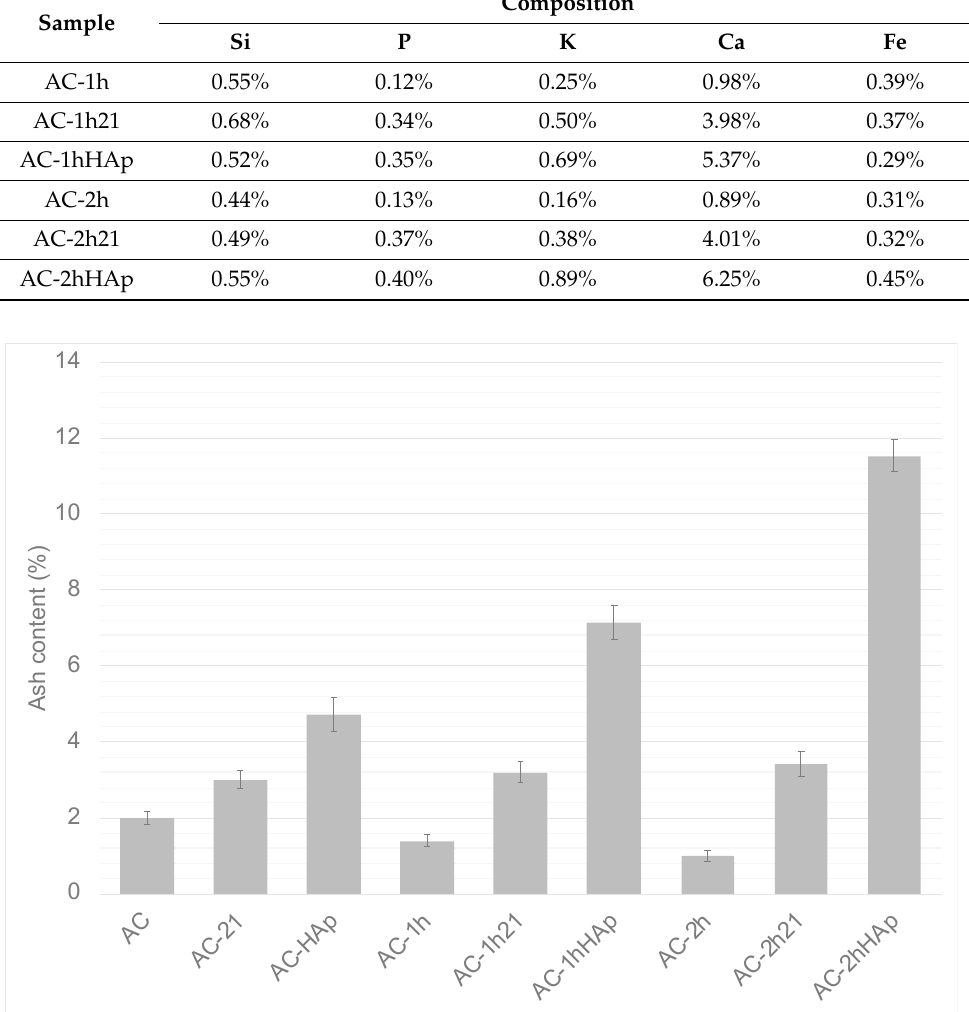
Figure 1. Ash content in percent of the different carbons tested (AC: activated carbon; 21: 21 days incubated; Xh: oxidized time; HAp: incubated for 21 days with CaSiO 3 ).